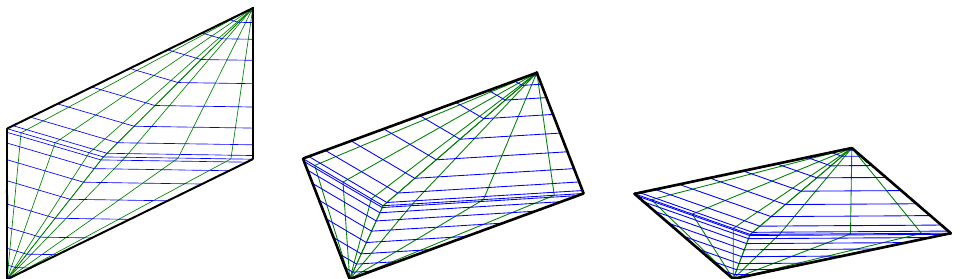
Figure 5. Special cases. ( left ): bv 0 space. ( middle ): original Hahn space h . ( right ): generalized Hahn space h d .